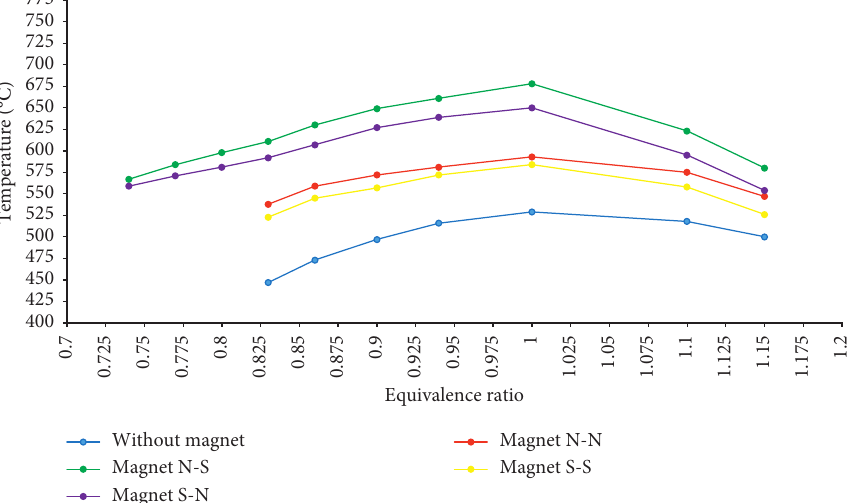
Figure 8: Flame temperature of coconut oil versus equivalence ratio at various magnetic field orientations and without magnetic